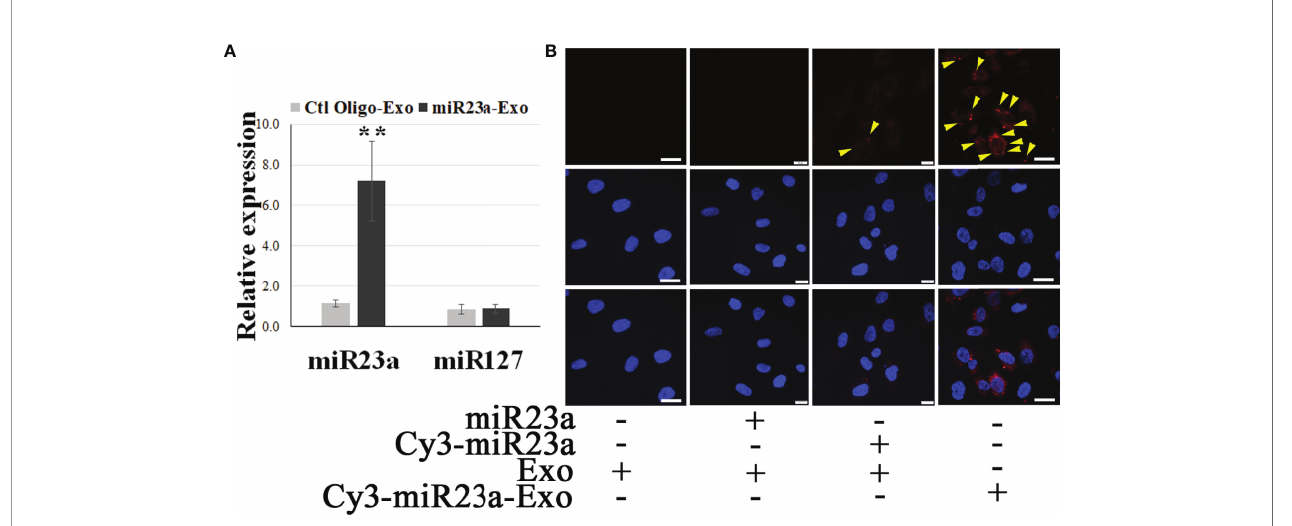
FIGURE 2 | ECExos can deliver miR23a mimic oligonucleotides to recipient BMECs in the presence of RNases. (A) Stem-loop PCR of miR23a and miR127 in miR23a-enriched ECExos (miR23a-Exo) or negative control oligonucleotides-enriched ECExos (Ctl Oligo-Exo) using a published protocol (50). ** p <0.01. (B) Fluorescent tracking of naked mir-23a or miR23a-Exo in BMECs in normal culture media after treatment for 12 hr.